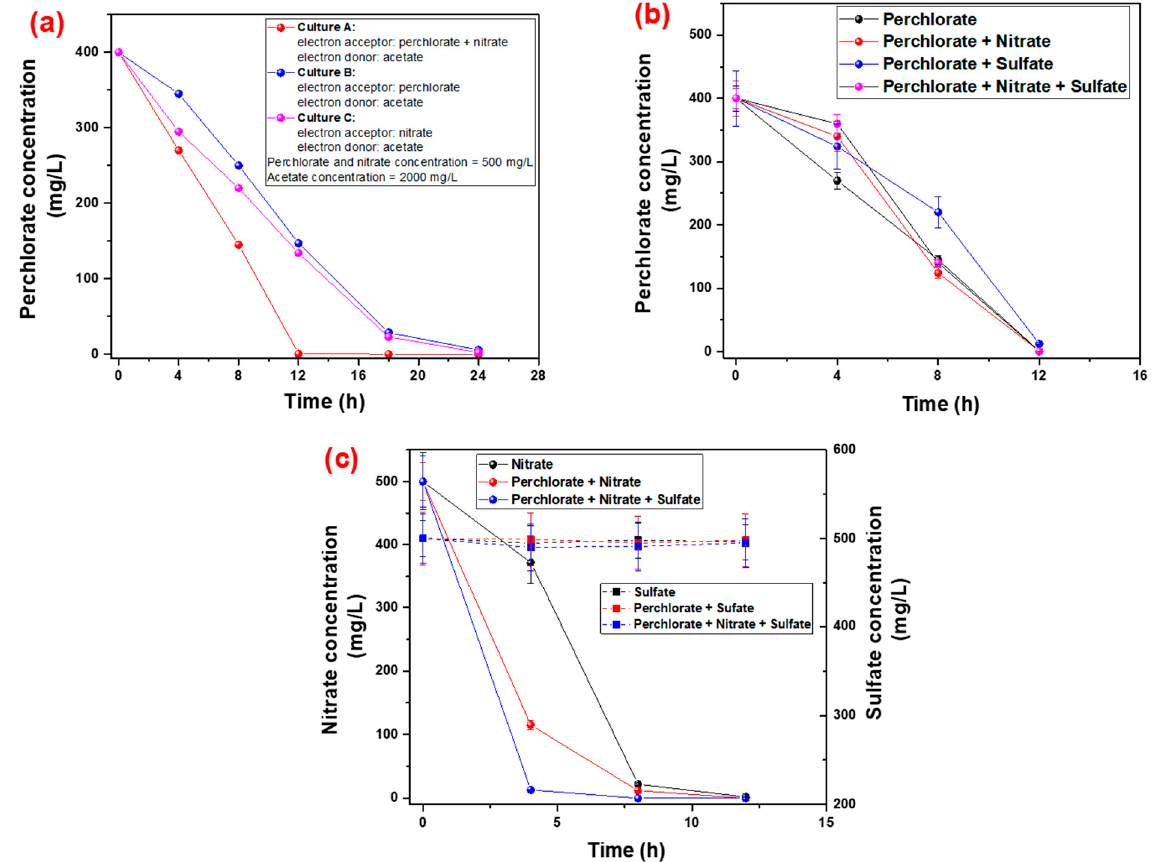
Figure 1. ( a ): Perchlorate reduction by mixed microbial culture grown under different combinations of perchlorate and nitrate as the electron acceptor and the acetate as electron donor; ( b ): impact